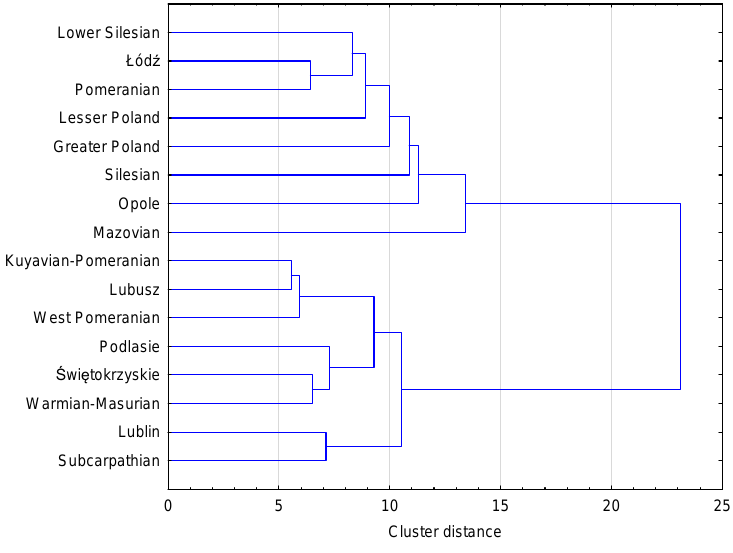
Figure 4. Clusters of Polish Voivodeships with similar social and economic development levels in